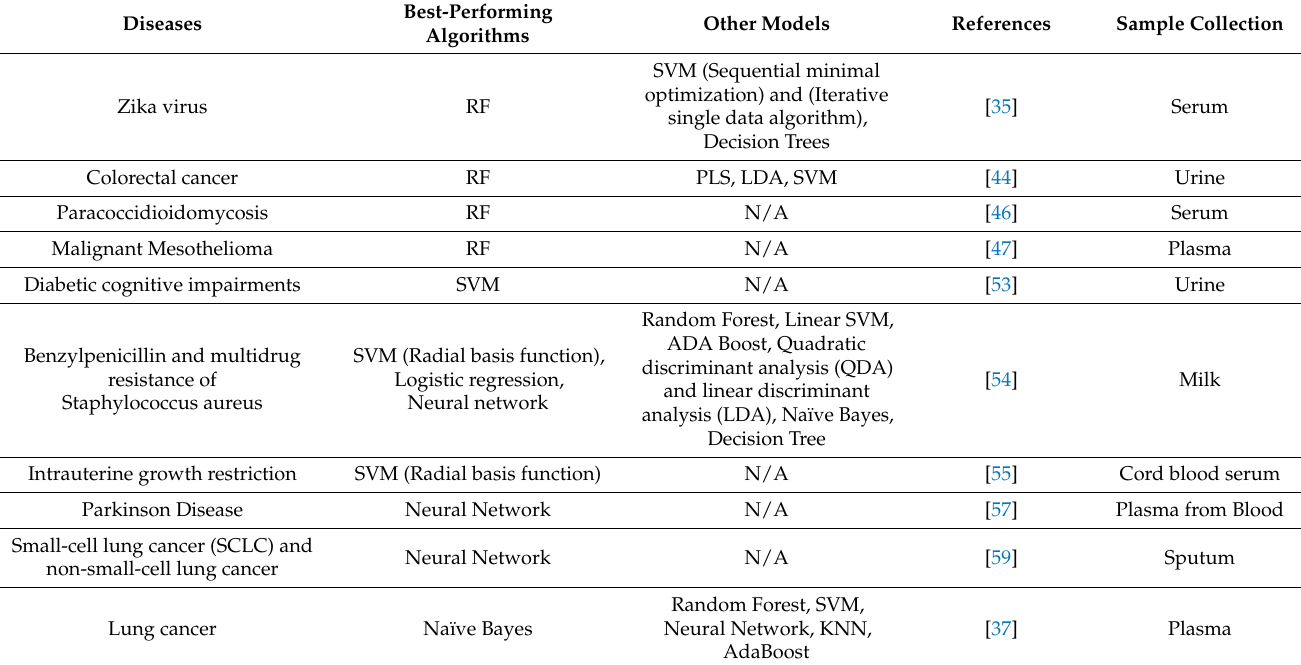
Table 2. Recent application of machine learning algorithms coupled to metabolomics for the diagnosis of diseases. The diseases, the best-performing algorithm and the samples analyzed are